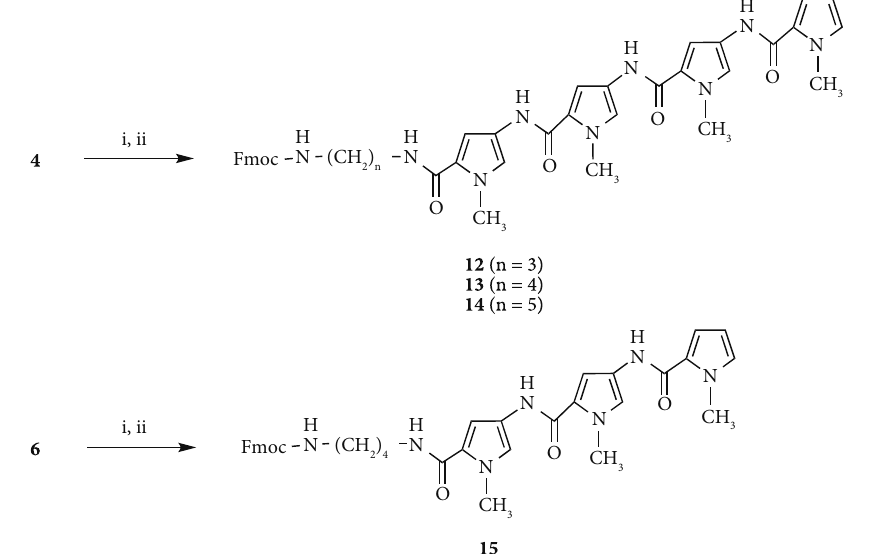
Scheme 3: Synthesis of pyrrole polyamides bearing aminoalkyl linker. Reagents and conditions: i 1 M NaOH aq./MeOH, 60 ° C; Dowex 50WX8 (H + -form); ii 9 , 10 , or 11 , DCC, HOBt, DIEA, DMF, and rt; 13 (71%); 14 (84%); 15 (61%). Compound 12 was prepared as previously described [10 – 13].